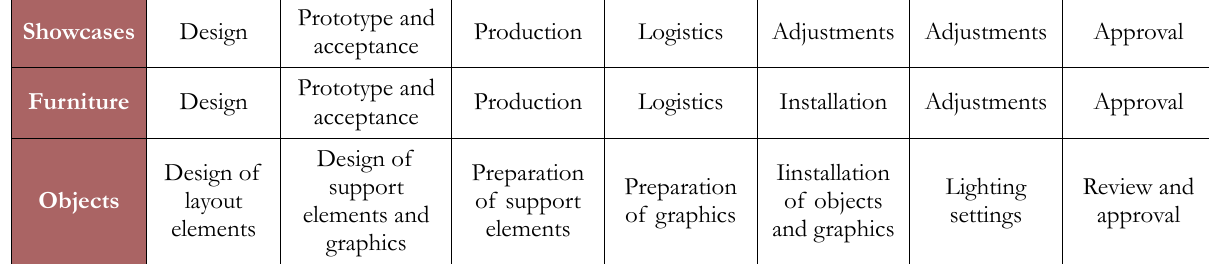
Table 1. The three main operational processes